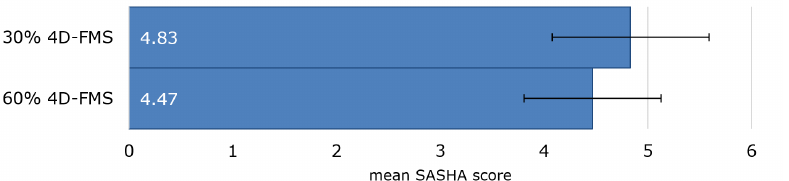
Figure 12. Mean SASHA scores for the scenarios (S30 vs. S60 vs. S80). Error bars represent standard